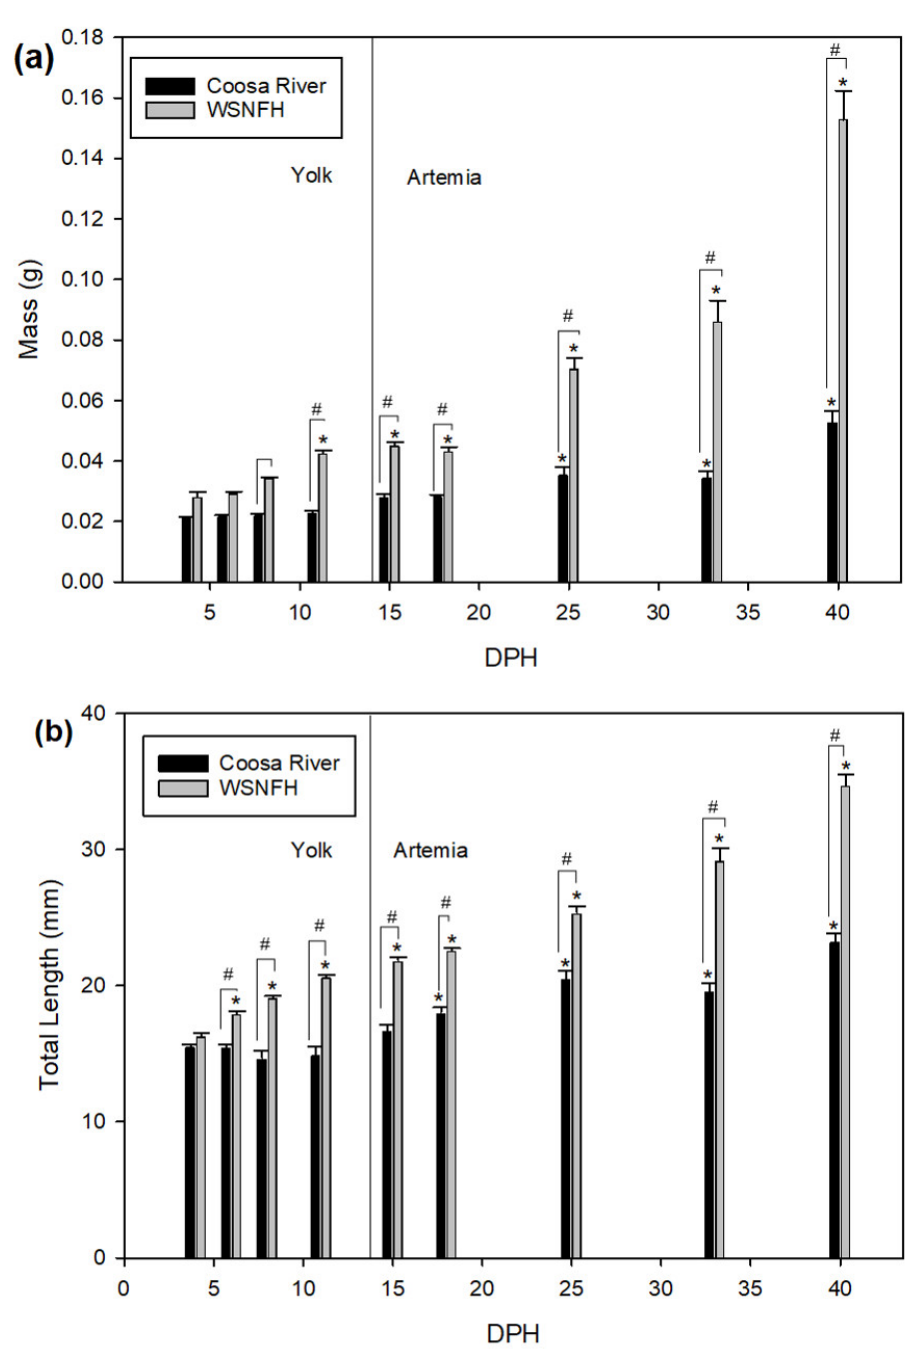
Figure 4. ( a ) Total mass without scutes and ( b ) total length of larval Lake Sturgeon ( n = 10–12 per sample point; 15 days post-hatch (dph), n = 3). Black bars represent fish reared in Coosa River water and gray bars represent fish reared at the Warm Springs National Fish Hatchery (WSNFH). * = significant difference between sample point and 4 dph within the treatment. # = significant difference between treatments for that sample point. Larvae relied on yolk from 0 to 14 dph and were fed live Artemia from 15 to 40